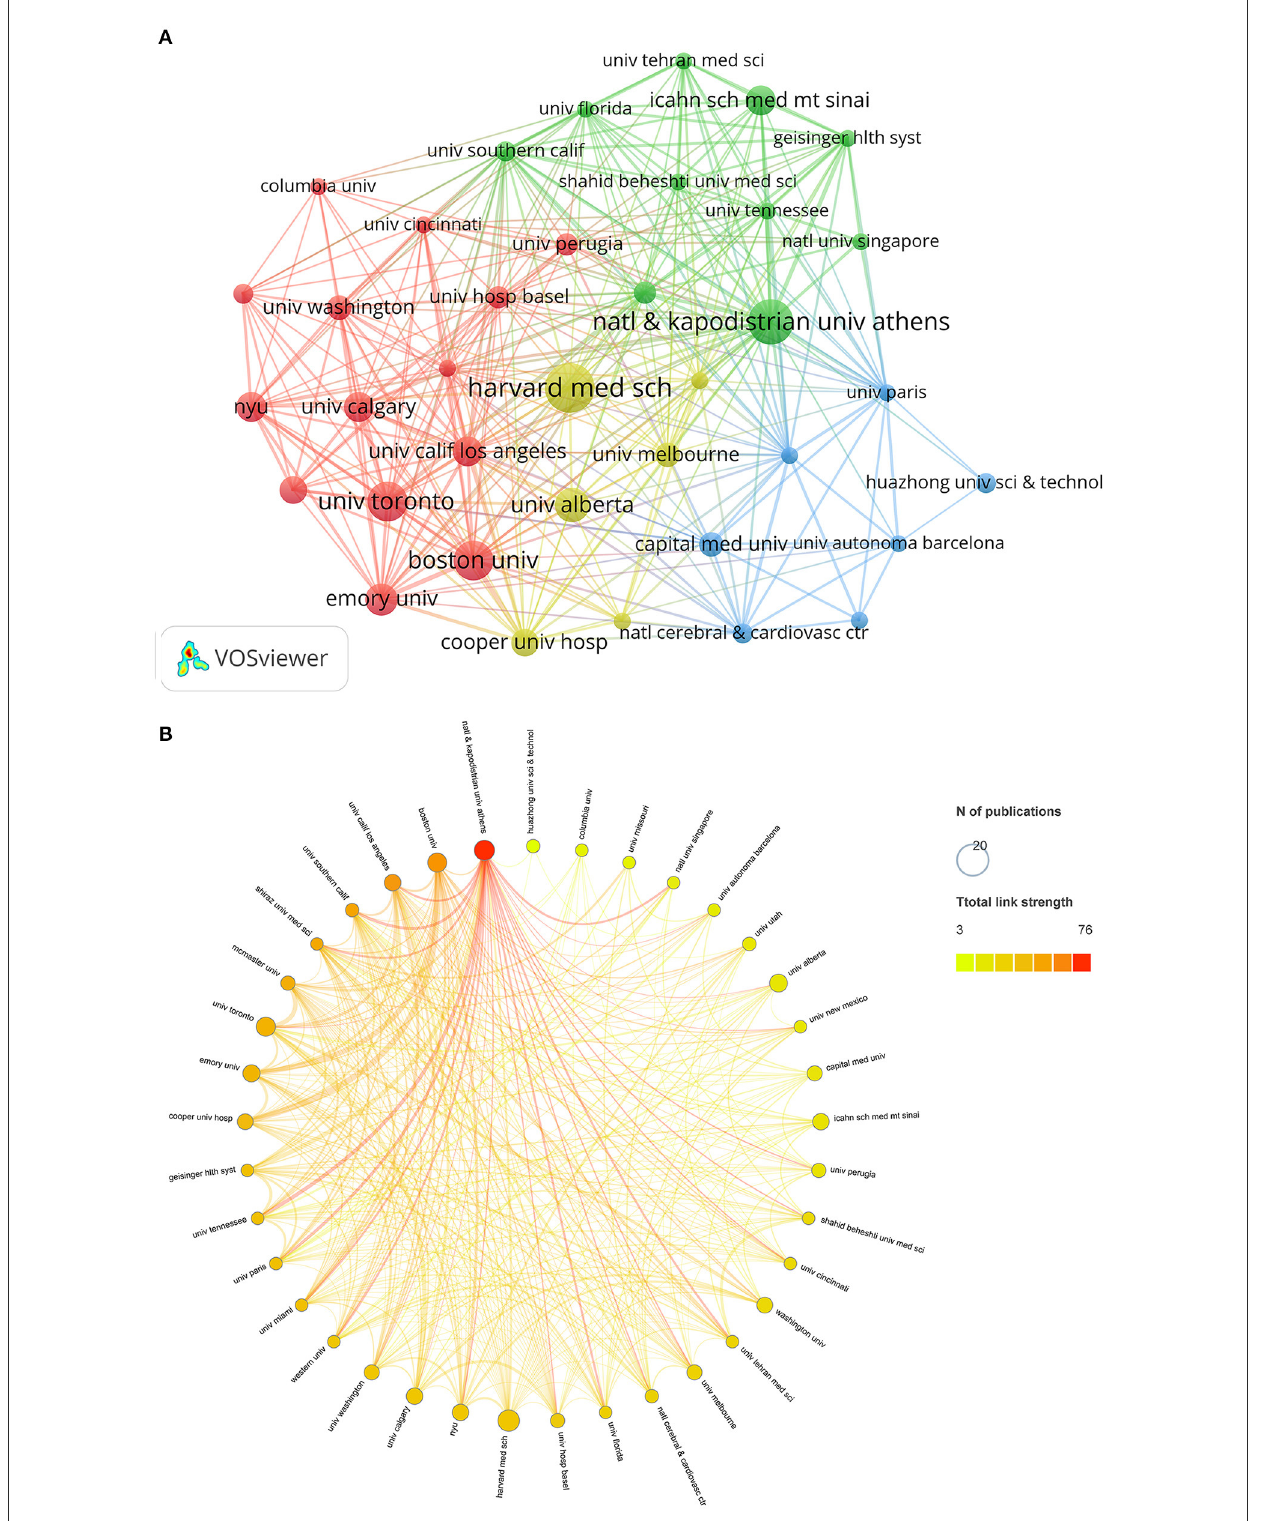
FIGURE4 Institution co-authorship networks. (A) Co-occurrence network of institutions generated by VOSviewer. The size of the nodes represents the number of publications. The size of the nodes represents the number of publications of each institution, and the distance between nodes and the thickness of the link represents the intensity of cooperation between institutions. (B) Scimago Graphica-generated chord diagram of institution cooperation network. The size of the nodes represents the number of publications, and the color of the nodes represents the intensity of cooperation between